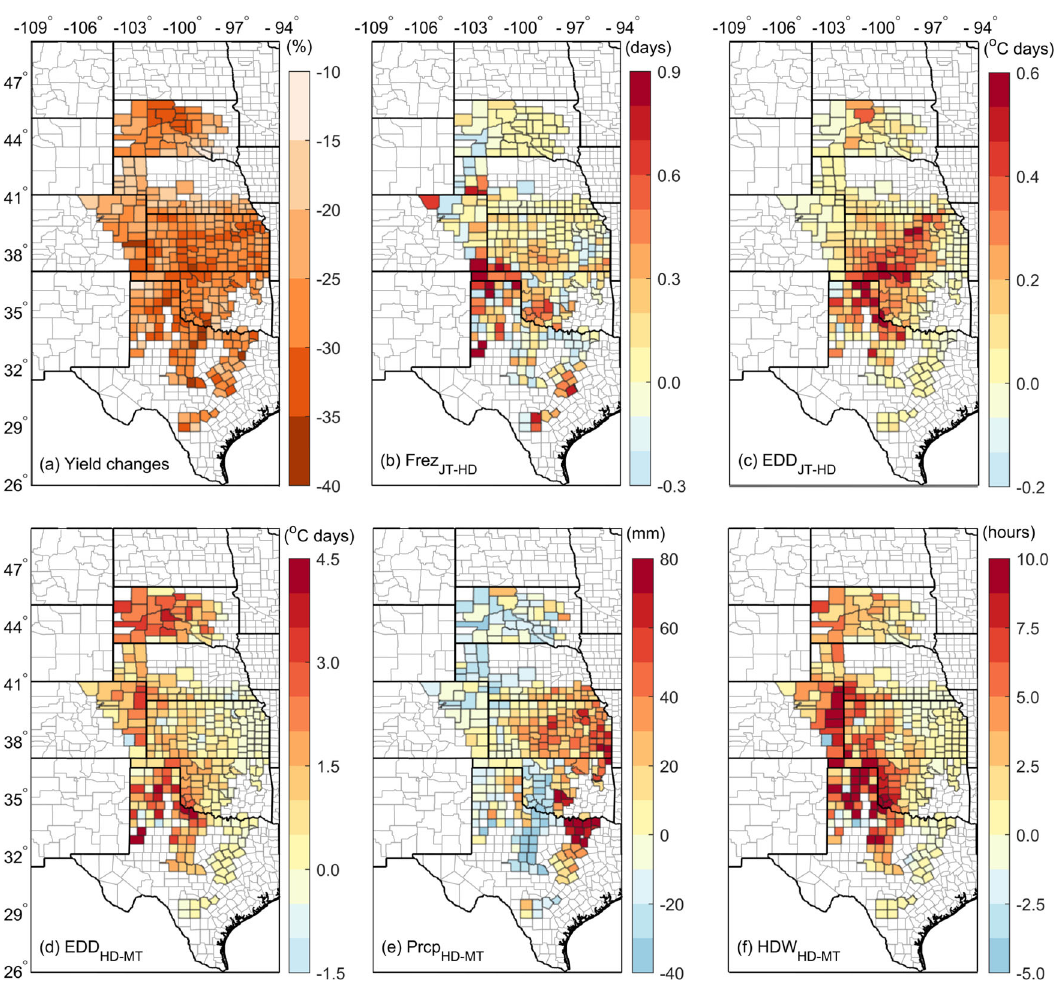
Fig. 5 | Yield shock distributions and a decomposition of yield shock drivers. a Spatialdistributionofthecounty - levelyieldshock. b – f Theconcurrentchangesin climate indices including freezing days (Frez, ( b )), extreme degree days (EDD, ( c ))